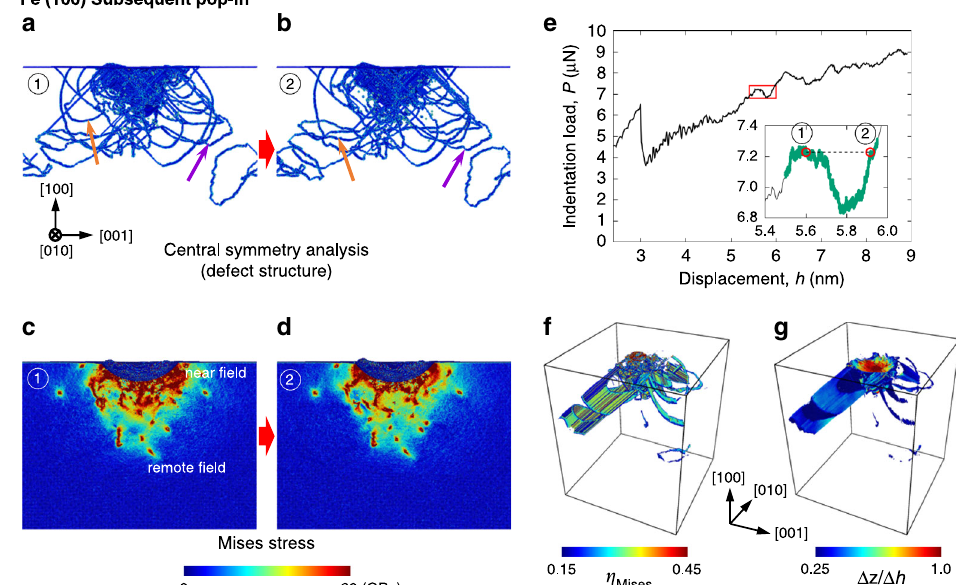
Fig. 4 Subsequent pop-in behavior in molecular dynamics simulation at 5 K on the (100) BCC Fe surface. Defect structure immediately ( a ) before and ( b ) after a subsequent pop-in (central symmetry parameter coloring 43 ), von Mises stress distribution immediately ( c ) before and ( d ) after a subsequent pop-in, and ( e ) the corresponding load-displacement curve. f Spatial distribution of von Mises atomic-strain-invariant η Mises . Only atoms satisfying η Mises > 0.15 are displayed. g Spatial distribution of atomic displacement along loading direction ([100]), Δ z , normalized by displacement burst Δ h . Only atoms satisfying Δ z / Δ h > 0.25 are displayed. The von Mises stress distribution is shown on a (010) plane passing through the indenter central axis. The movies of the dislocation pattern and the stress-distribution evolution during the simulation can be found in Supplementary Movie 1. See also Supplementary Note 16 for (111) BCC Fe and (100) FCC